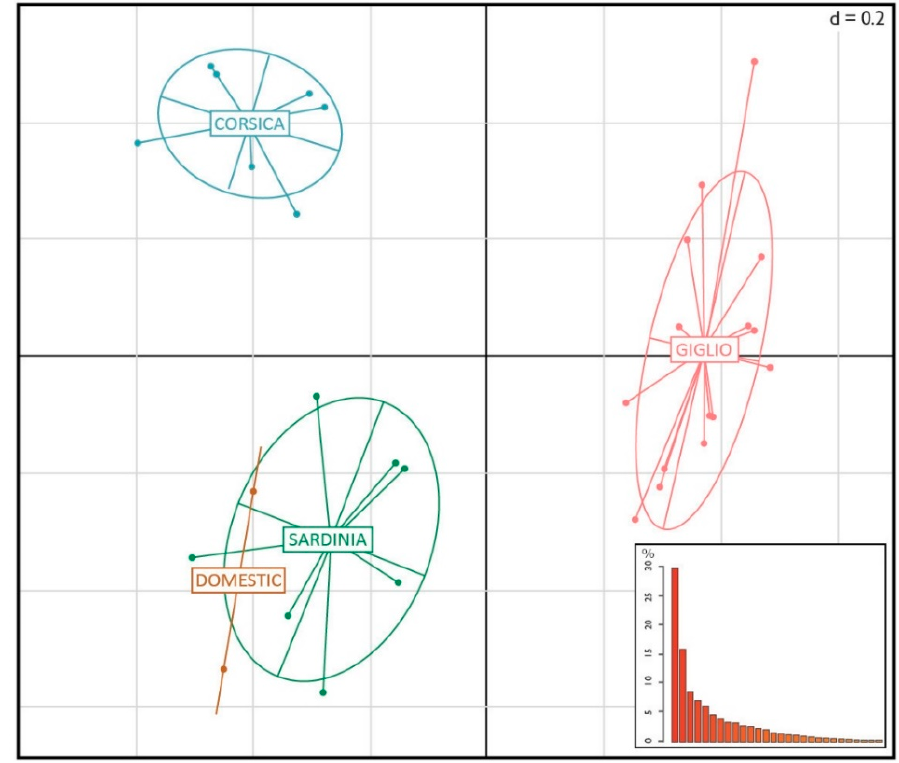
Figure 3. PCA of four mouflon and one domestic population, X and Y axes represent the first and second PCs, respectively. The inset shows the importance of each PC in terms of percentage of total variance explained.